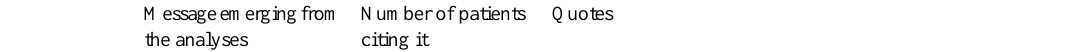
Table 2. Levers and barriers to physical activity and mHealth use.